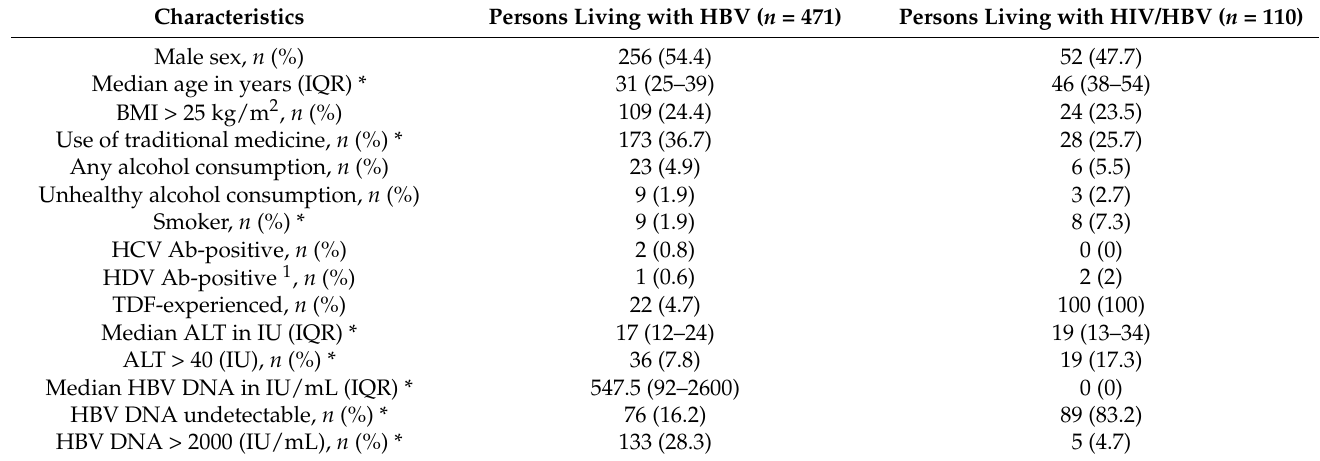
Table 1. Characteristics of the study population at the time of liver fibrosis assessment, by HIV co-infection